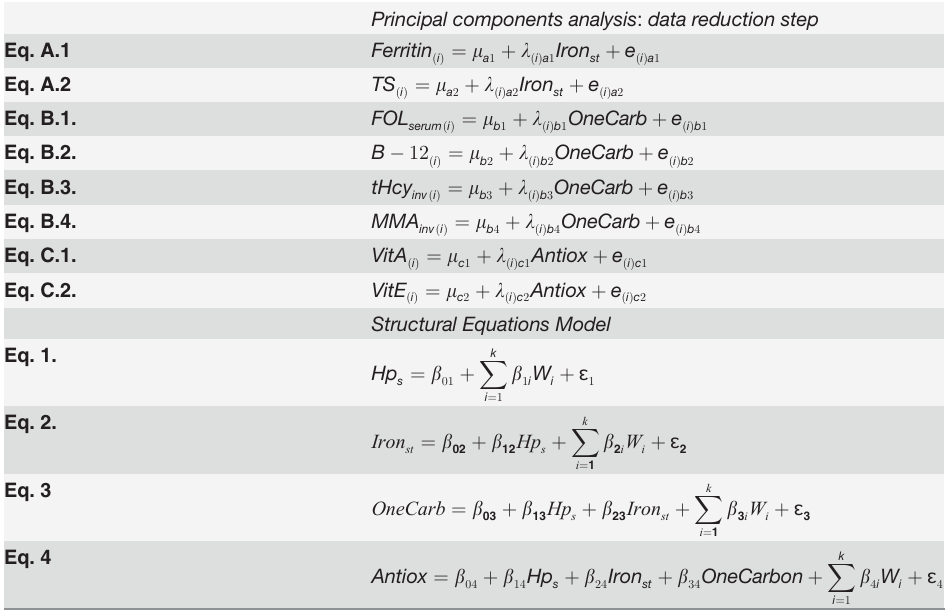
Table 1. Data reduction and structural equations model. Principal components analysis : data reduction